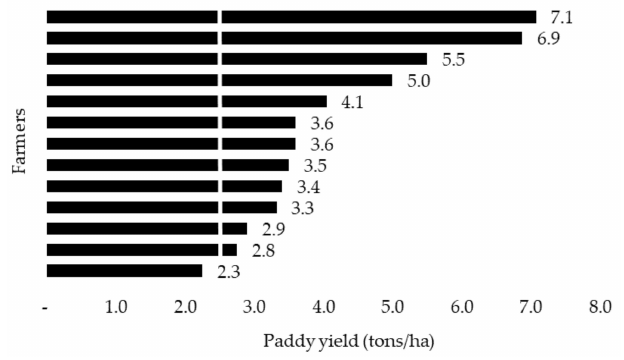
Figure 5. Yield of NARORICE-1 on fields of 22 of the 40 farmers who received seed and technical support throughout the season. The white vertical line represents the current national productivity average of 2.5